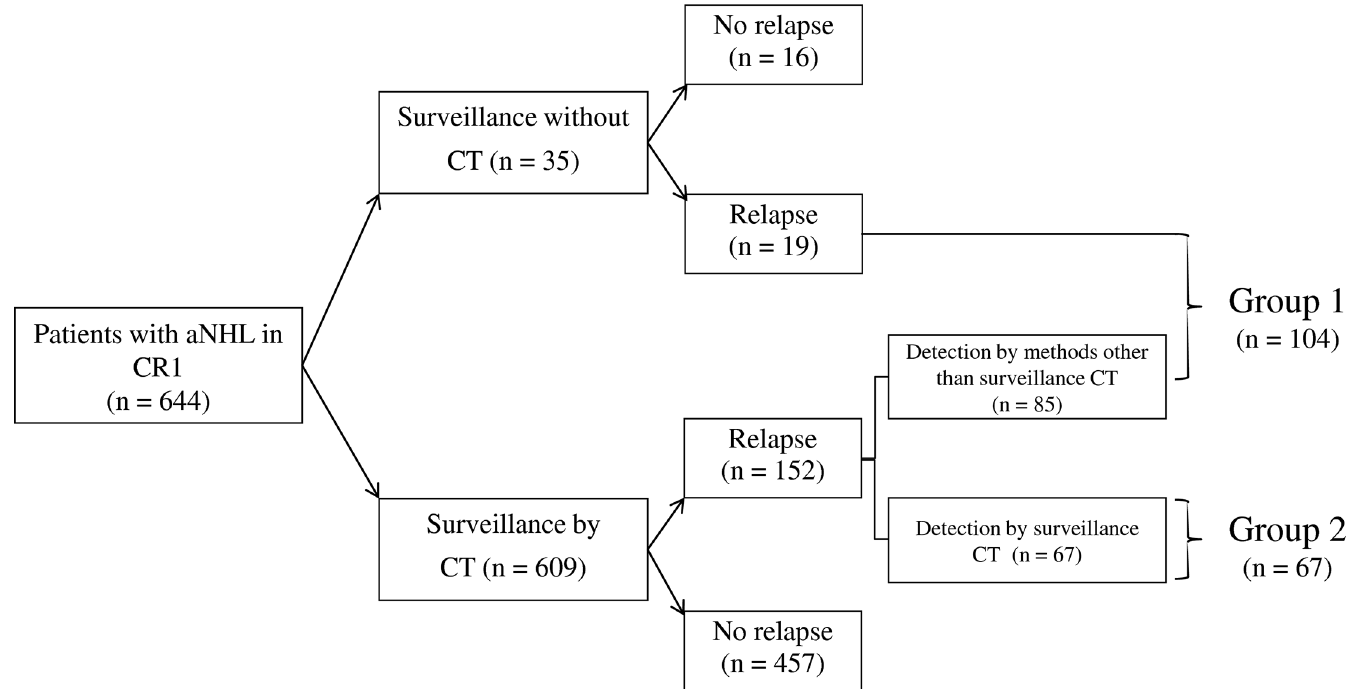
Fig 1. Diagram of the composition of patients in this study. Abbreviations: aNHL, aggressive non-Hodgkin lymphoma; CR1, complete remission after frontline chemotherapy; CT, computed tomography.